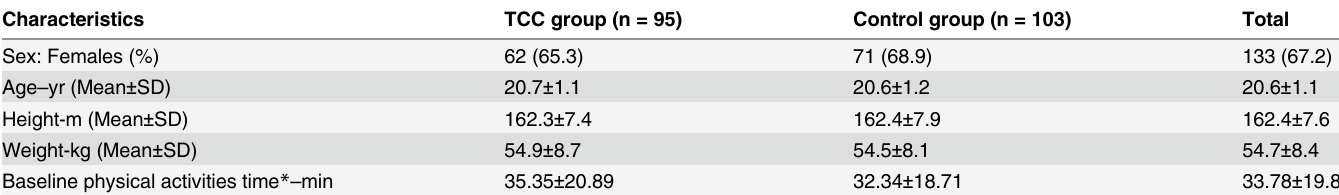
Table 1. Baseline characteristics between the TCC exercise and control groups.